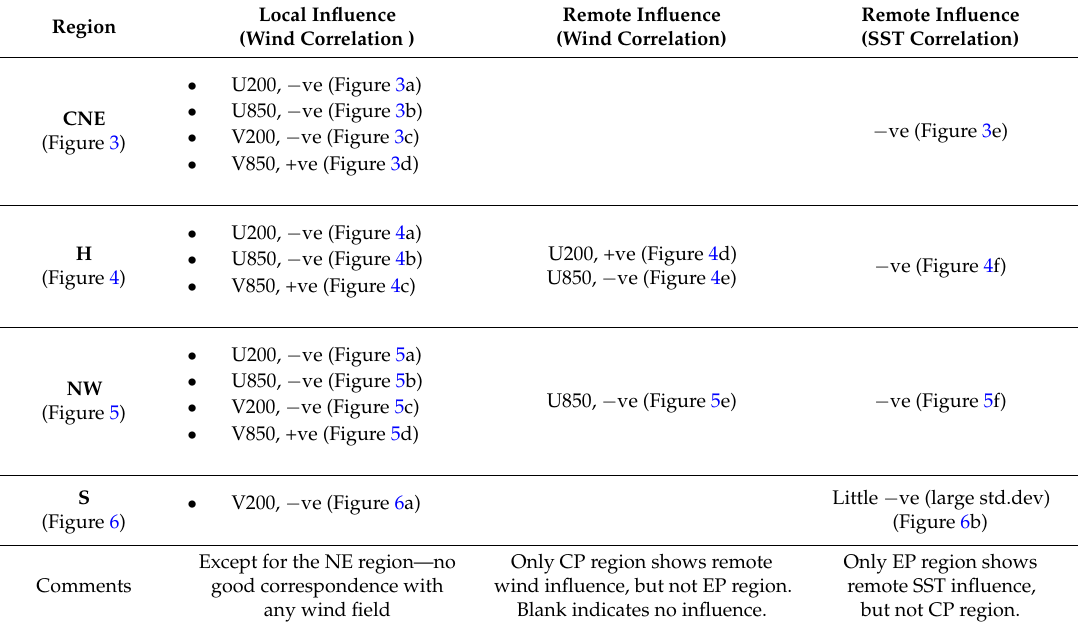
Table 2. Influence on local precipitation via local wind or from remote regions (tropical Pacific). Region